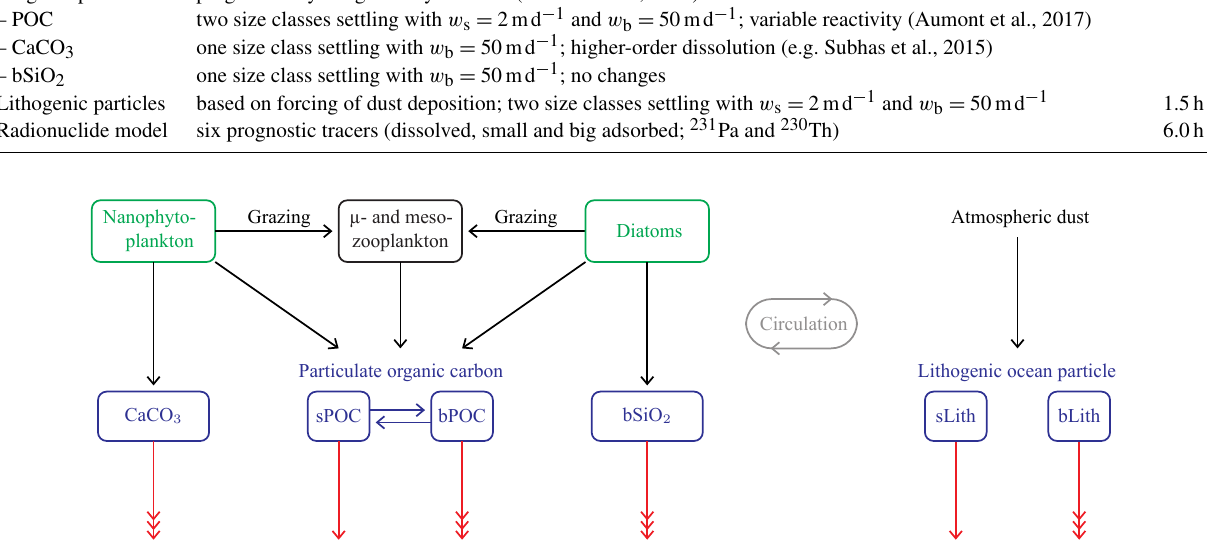
Figure 1. Conceptual model of the particle dynamics on which the numerical model is based. Nanophytoplankton and diatoms (in green) take up nutrients and CO 2 , which are released again from respiration and remineralisation of bSiO 2 , POC, dissolved organic matter and lithogenic particles. The nutrients, CO 2 and dissolved organic matter are not represented in the figure because only particles impact 231 Pa and 230 Th. Zooplankton are denoted by the black box. All sinking particles are denoted by blue boxes. Effectively, this figure comprises the internal cycling of PISCES, minus details that are not of interest here, plus the lithogenic dust model. Small and big particulate organic matter is denoted by sPOM and bPOM, both subject to the differential lability scheme (Aumont et al., 2017), and bSiO 2 stands for biogenic silica. Similarly, sLith and bLith stand for small and big lithogenic particles. Sinking is denoted by the red arrows; triple arrows mean fast, and normal arrows slow.